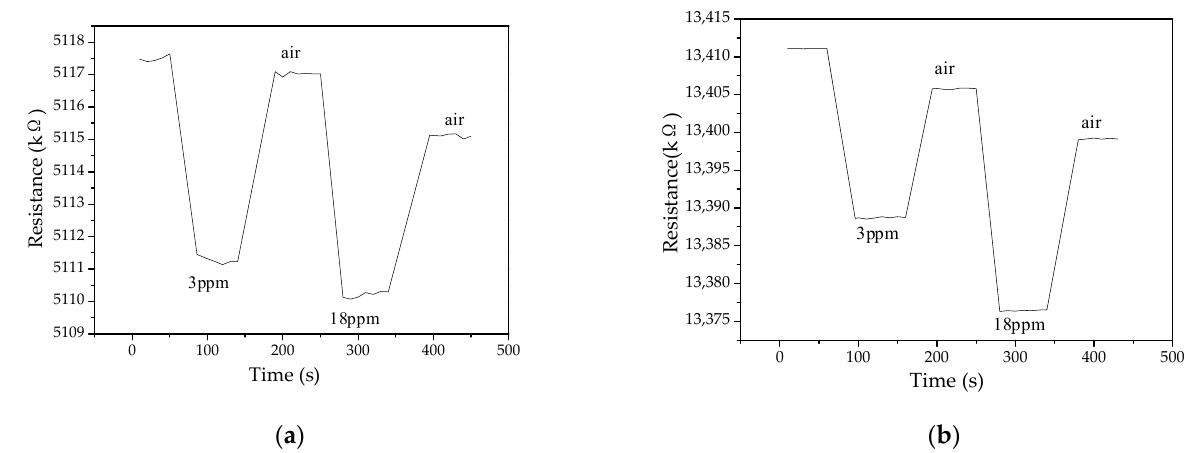
The change in the PANI and PANI/SnO 2 gas sensor response curves with benzene